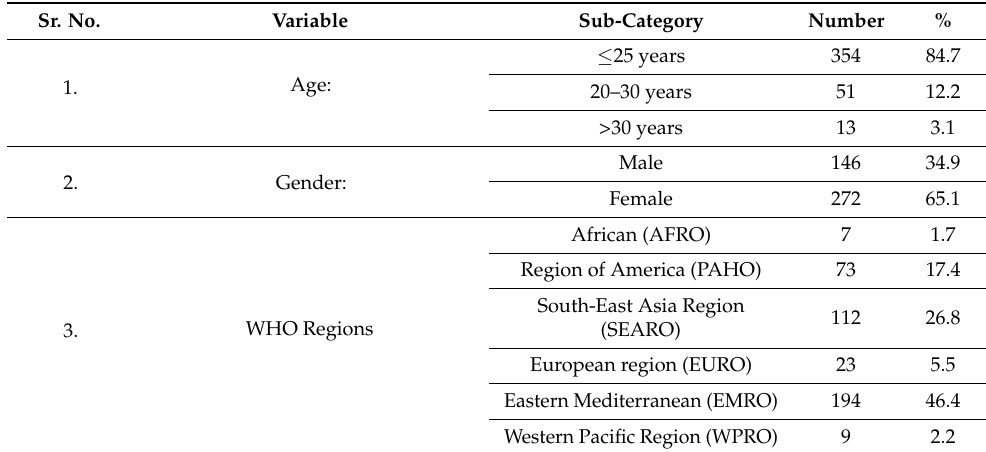
Table 1. Background characteristics of the